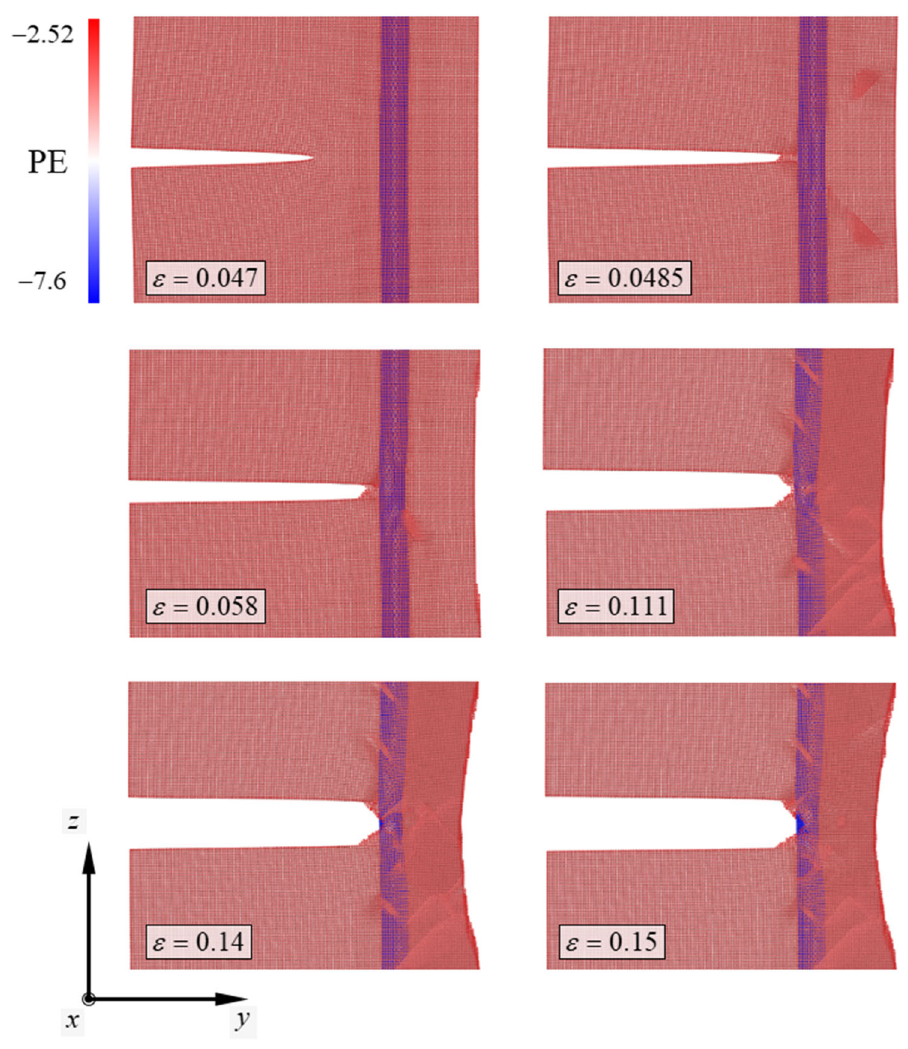
Figure 5. Atomic configurations depicting the deformation mechanism of the Cu/CNT composite containing the (19,19) CNT. PE denotes potential energy of the atom consisting of the simulation model. The numbers next to the color bar denote the range of the PE and SI unit of the PE is eV. Table 4. Failure strength and surface energy γ s of the simulation models in this study. “Pure Cu” indicates the failure properties of the pure Cu specimen with a half nanocrack. The experiment indicates the experimental value of the Cu/CNT